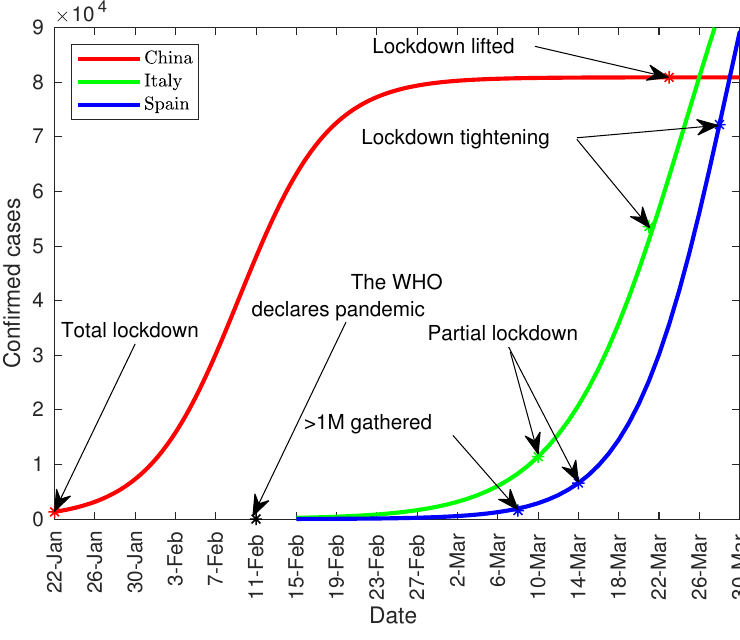
Figure 1. Timeline of the most relevant